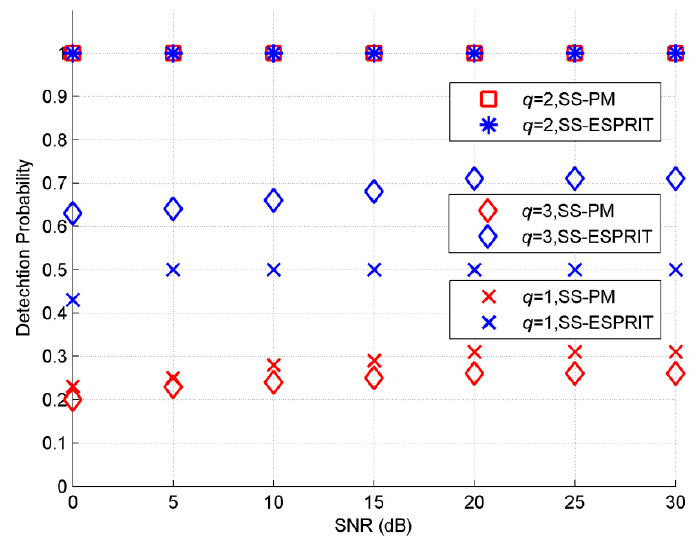
Figure 6. Detection probability versus different q with respect to two 2D coherent CD sources.